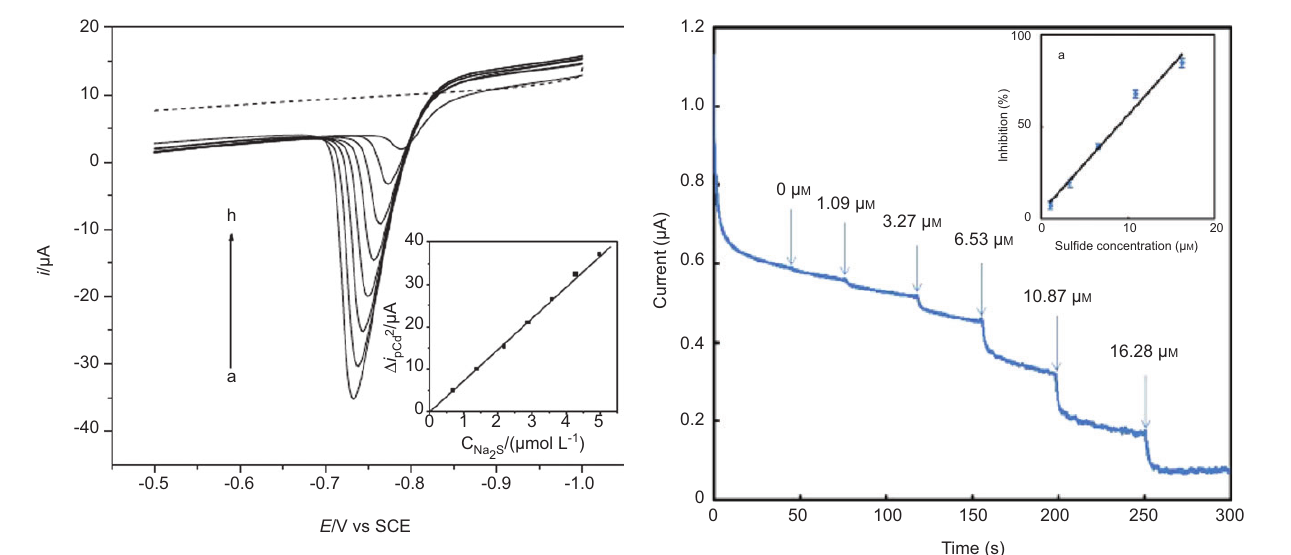
(CIP) on the surface of a screen printed electrode (SPE).